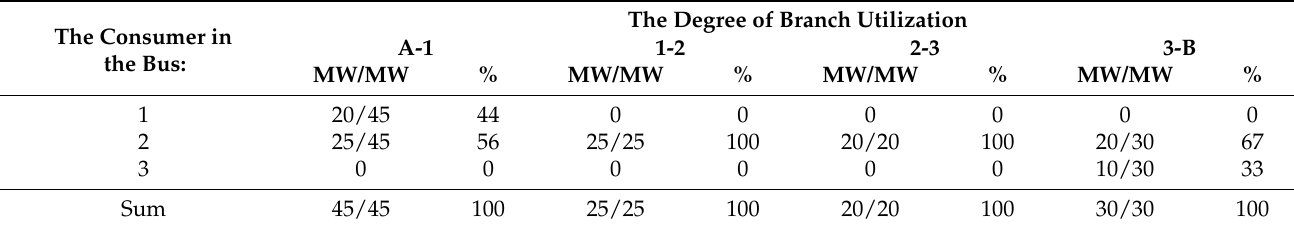
Table 3. The degrees of individual branch utilization by all consumers, resulting from the power flow decomposition by the power flow tracing method–the base case power flow.